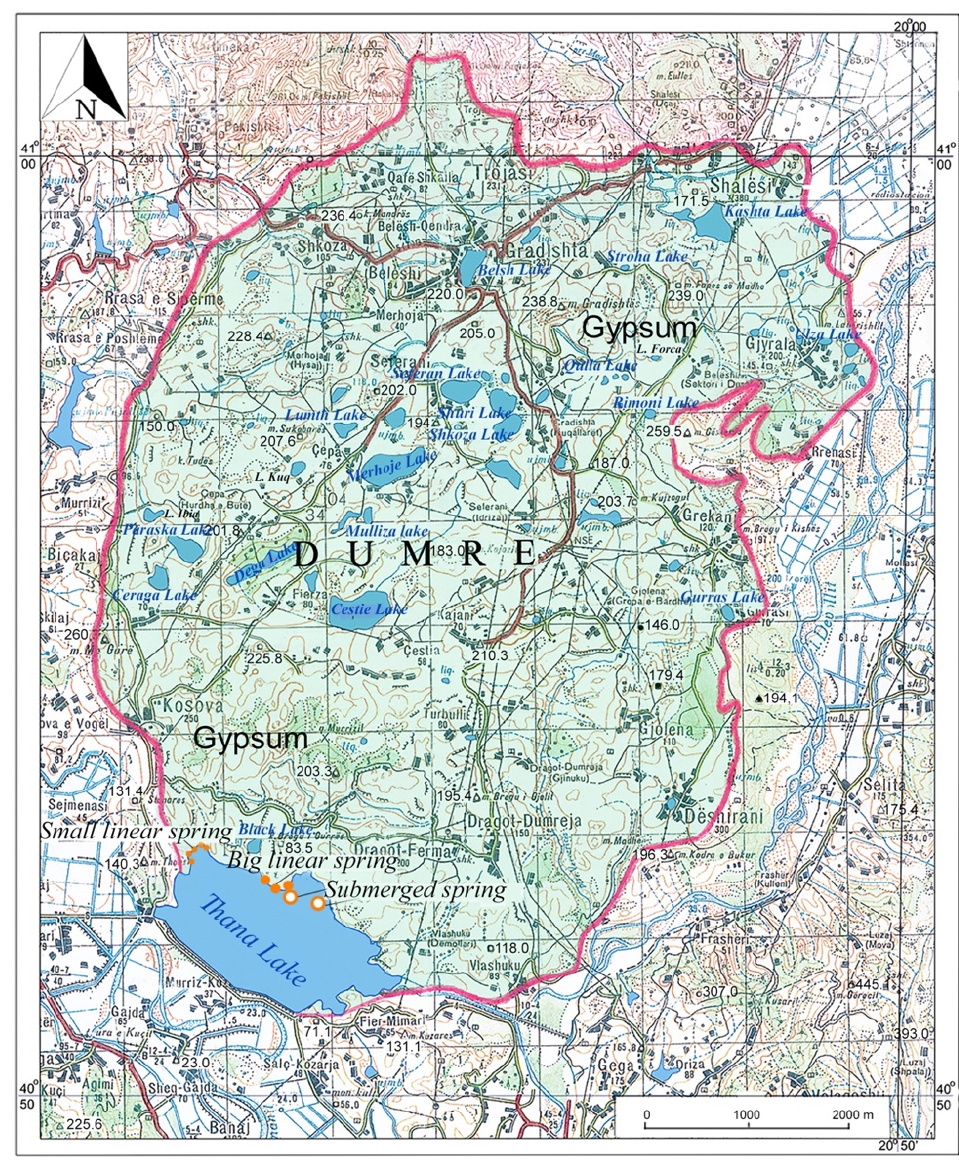
Figure 4. Topographic map of Dumre plateau, marked with the red line.